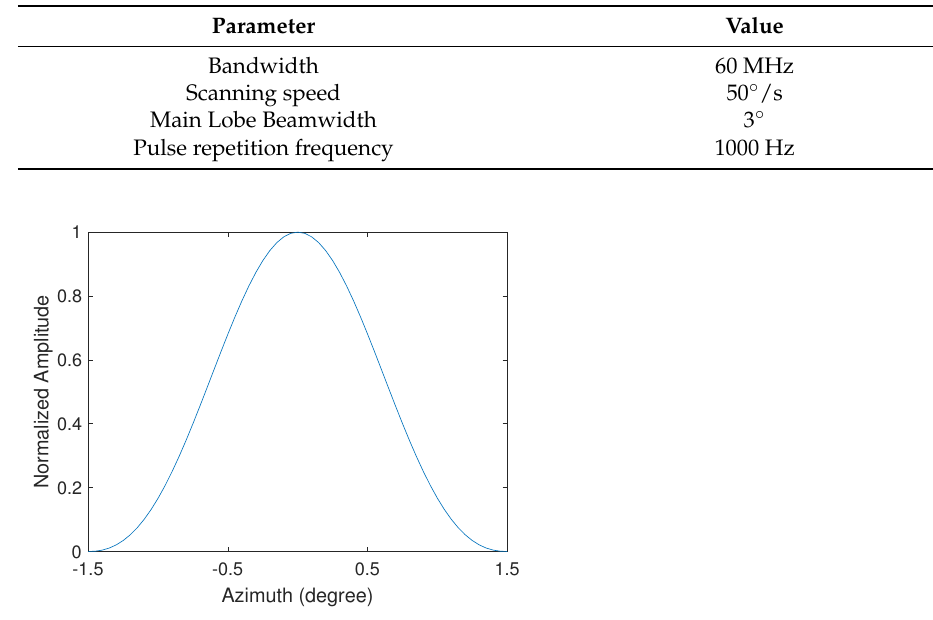
Figure 5. Antenna